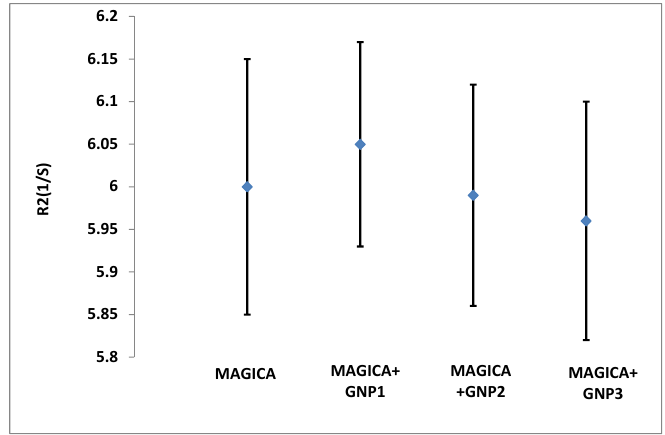
Fig. 4. Signal of non-irradiated gel samples with and without nanoparticles Fig.5